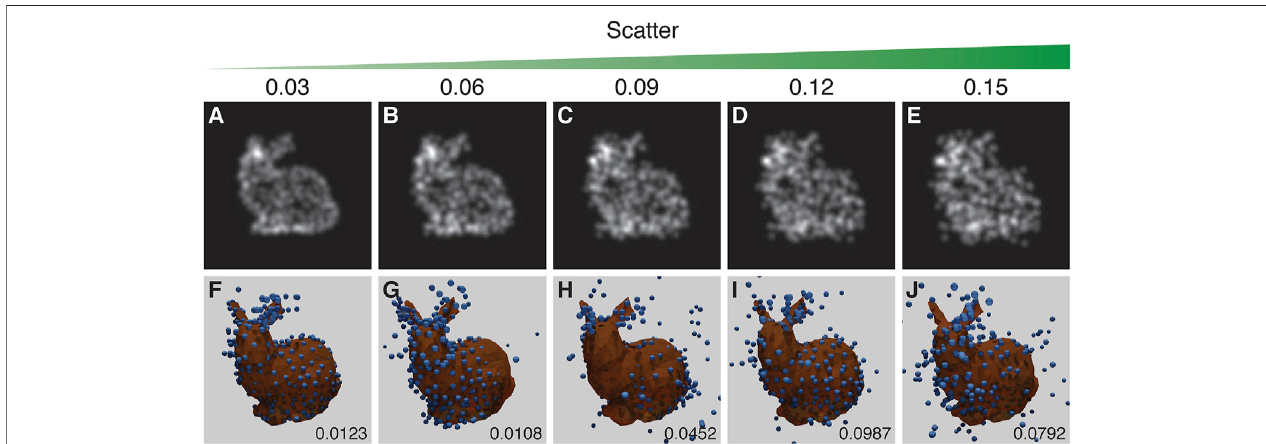
FIGURE 7 | The results of the experiment into the effect of scatter. Top row (A – E) : examples of training images treated with increasing scatter, as indicated by the scatter value above each panel. Bottom row (F – J) : the corresponding results with the inferred structure shown as blue spheres, overlaid and aligned with the ground truthmodelshowninorange.RSMDscoresareindicatedforeachruninthelowerrightcornerof (F – J) .Runsin (F) and (C) respectivelyshowedanincorrectsymmetryin structure and mirroring in a vertical plane. The parameters for this experiment can be found in Supplementary Table S5.4 .